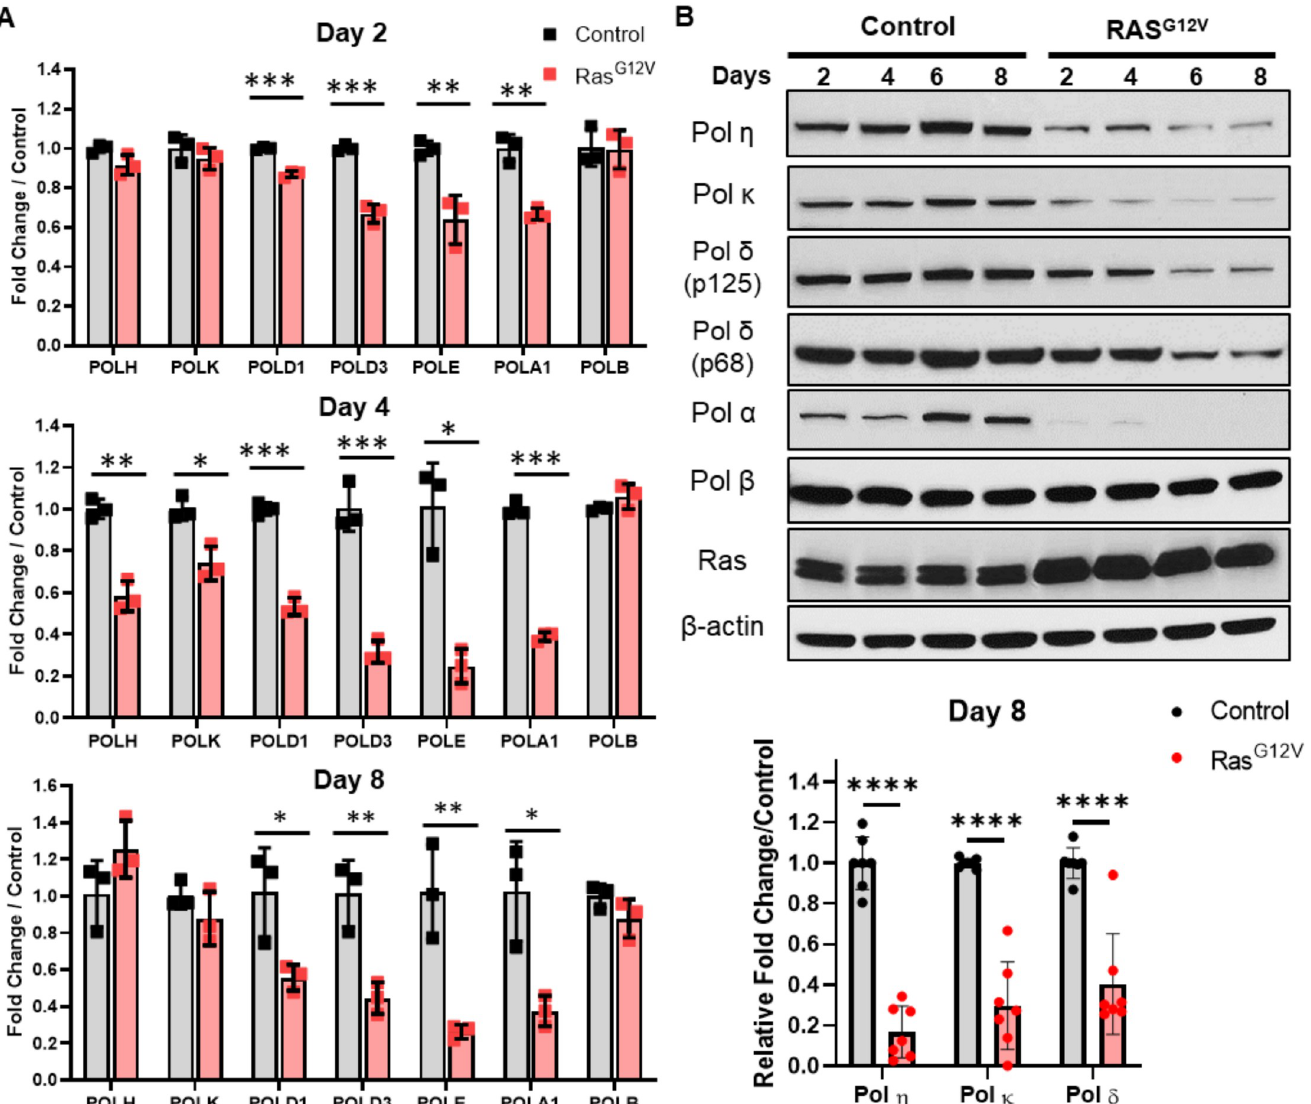
Fig 2. Overexpression of oncogenic Ras G12V induces downregulation of replication fork-associated DNA polymerases. (A). hTERT BJ5a human fibroblasts were infected with pBabe retrovirus empty vector (control; gray bars) or encoding mutant Ras G12V (red bars). POL gene expression was determined using qRT-PCR at the indicated timepoints after selection. Data represent mean +/- SEM of three biological replicates. (B). Top panel -Immunoblot analyses of representative control and Ras G12V -infected cell populations at indicated timepoints. One of three biological replicates is shown. Bottom panel- Quantification of DNA polymerase protein levels 8 days after control or Ras G12V transduction. Data represent mean +/- SD of seven biological replicates.